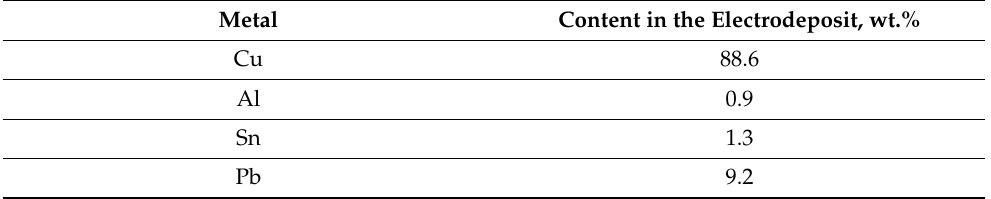
Table 3. The composition of deposits obtained at − 0.60 V and 60 °C from leachate “L2” at pH 6.5. Metal Content in the Electrodeposit, wt.%